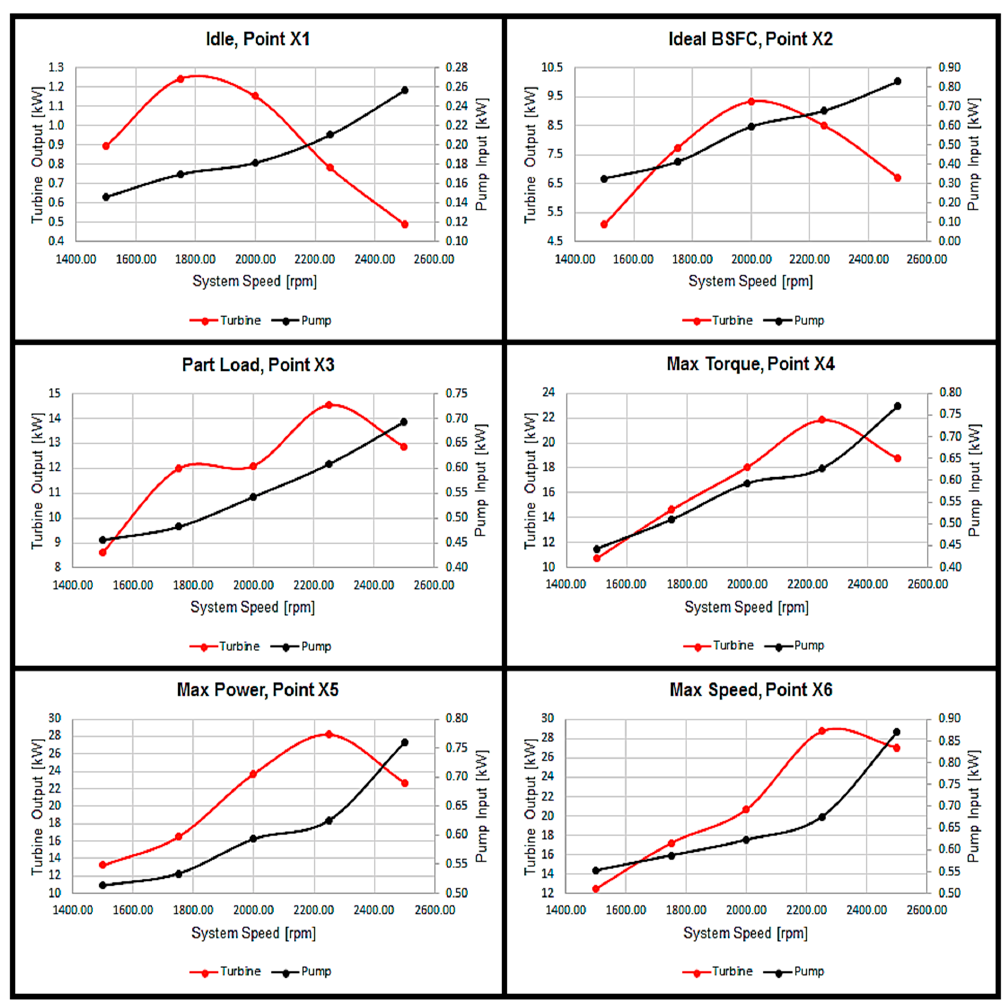
Figure 12. ORC system turbine power output in relation to system speed variation. Table 3. ORC system speed variation simulations.